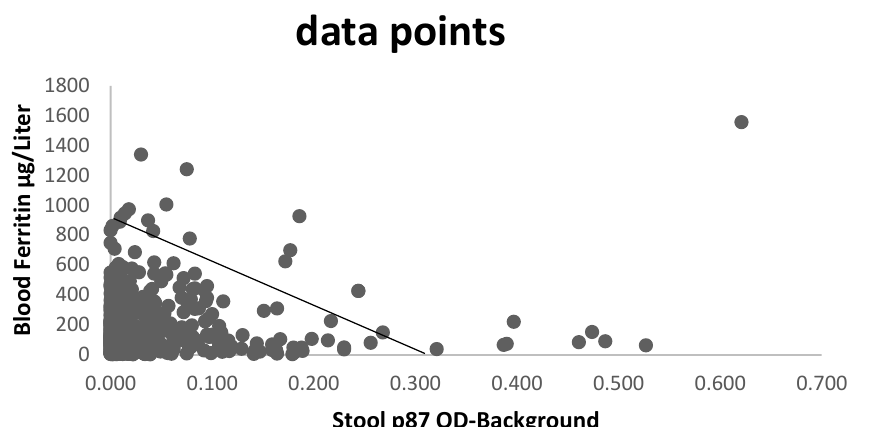
Figure 10. Scattergram of stool p87 negatively correlated with ferritin.